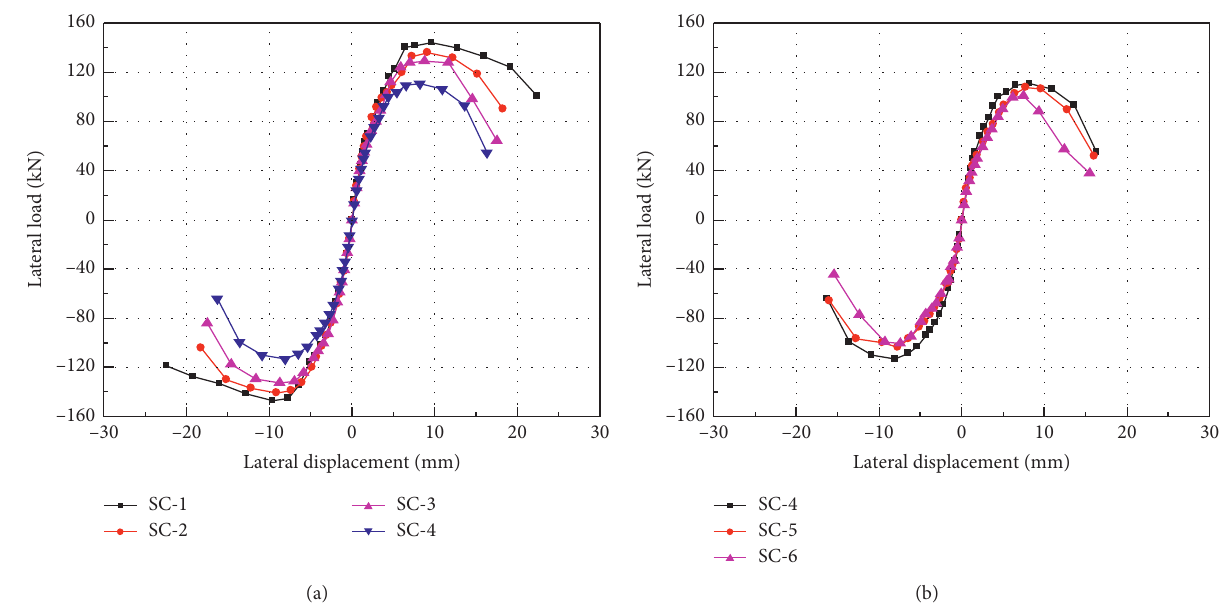
Figure 8: Skeleton curves of the specimens. (a) Corrosion-level-induced changes. (b) Stirrup-ratio-induced